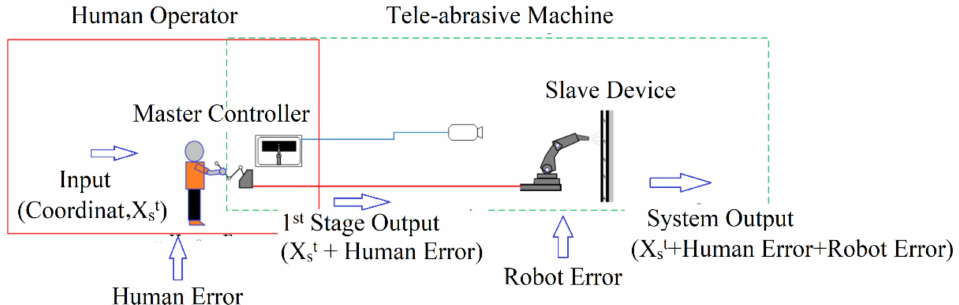
Figure 1. Tele-abrasive